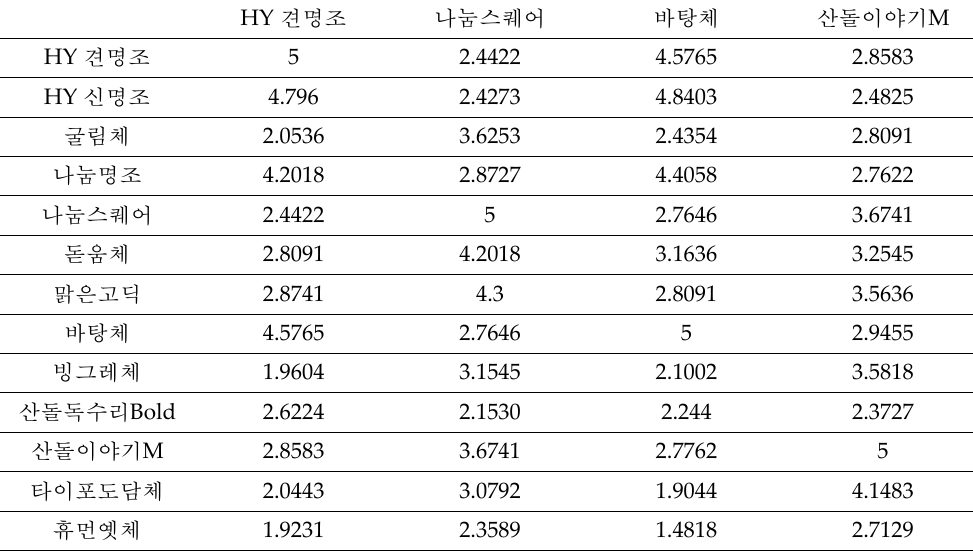
Table 9. Ground‑truth as a result of a large font